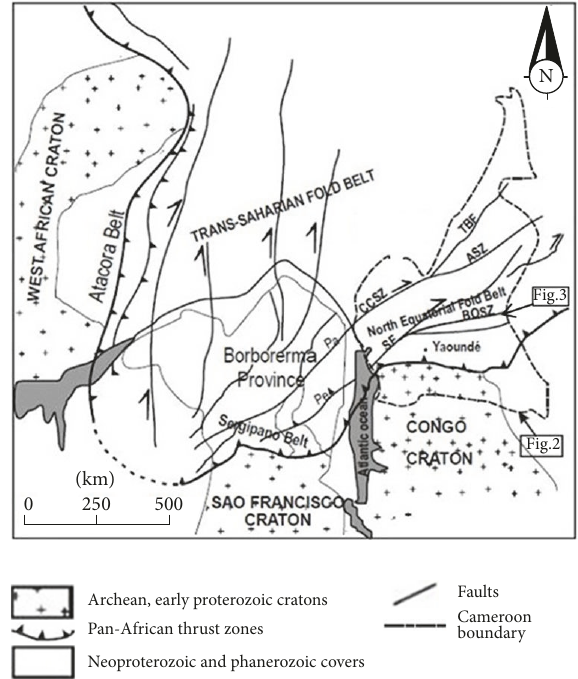
Figure 1: Predrift reconstruction of Pan-African and Brasiliano terranes (reproduced from Ganno et al., 2010, under the public domain; see location box in Figure 1): CCSZ: Central Cameroon Shear Zone; ASZ: Adamaoua Shear Zone; BOSZ: B´etar´e-Oya Shear Zone; SF: Sanaga Fault; TBF: Tibati Banyo Fault; Pa: Patos Fault; Pe: Pernambuco Shear